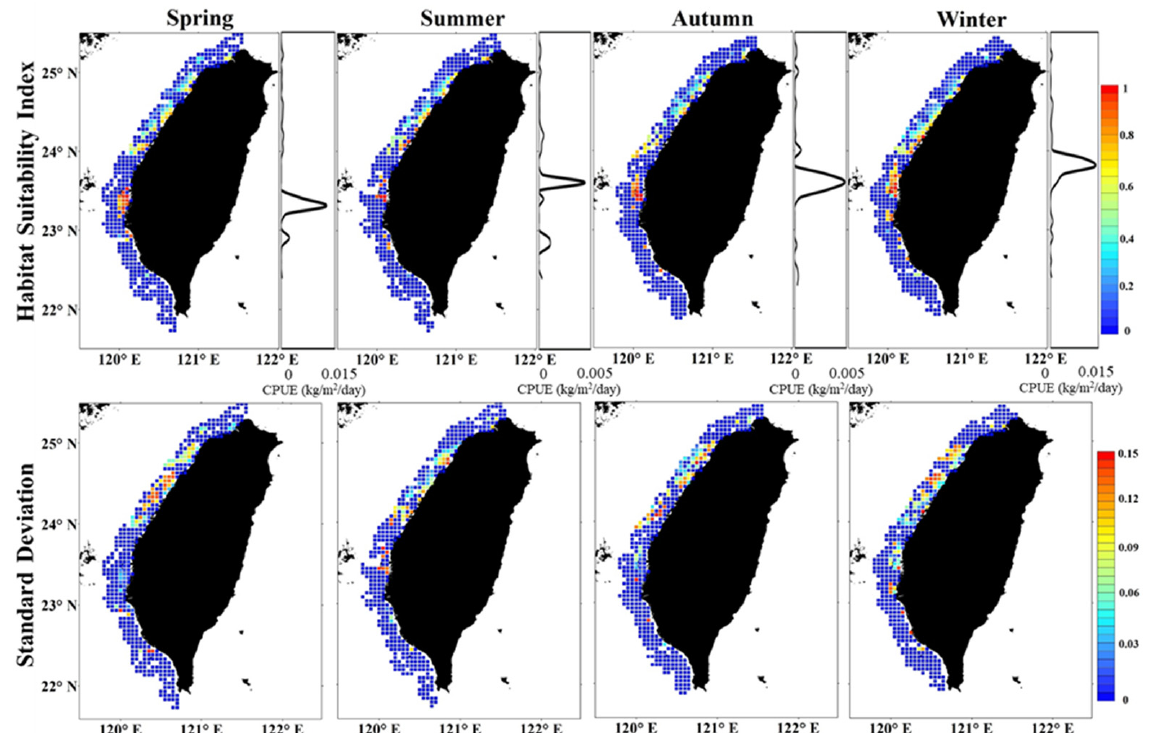
Figure 6. Habitat suitability index (top panels) and standard deviation (bottom panels) derived from the MaxEnt model by season. Top panels also indicate accumulated catch per unit effort by latitude.